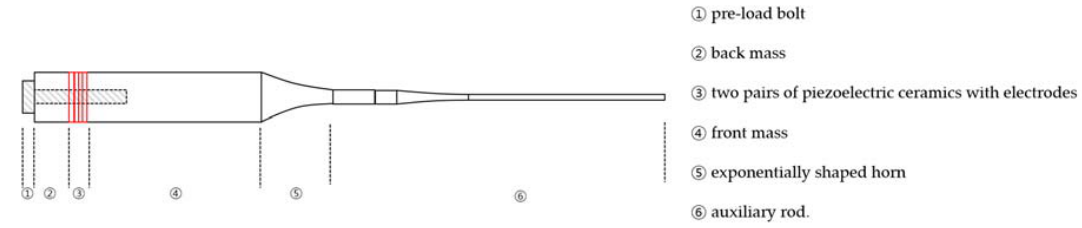
Figure 1. Structure of typical Langevin transducers.